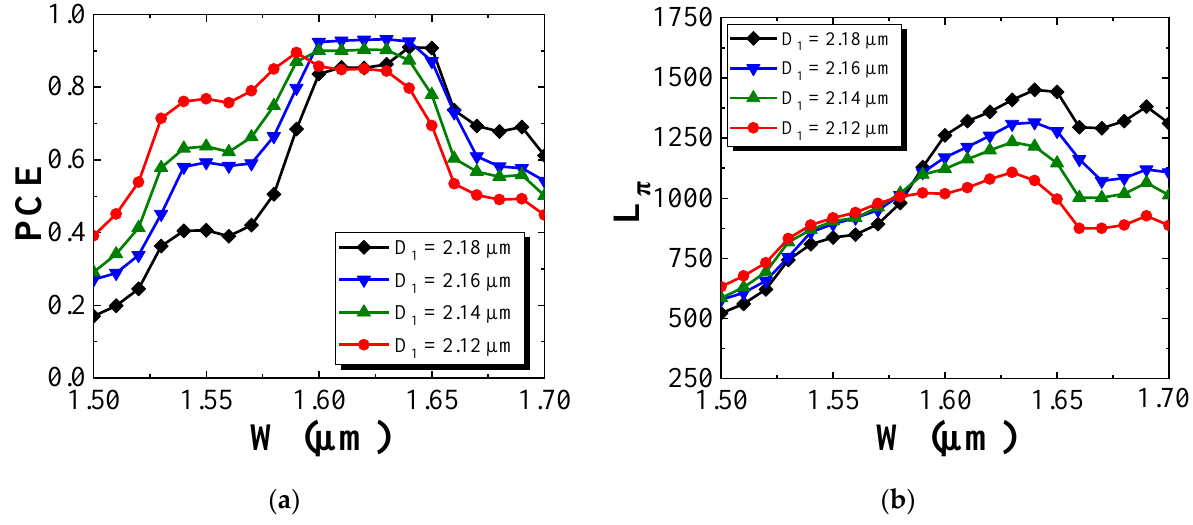
Figure 9. ( a ) Maximum PCE and ( b ) half-beat length, 𝐿 𝜋 , as a function of the waveguide width W .